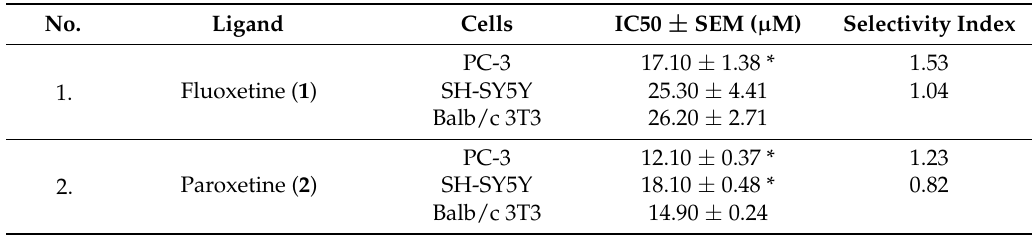
Table 2. Effect of new and classic selective serotonin reuptake inhibitors (SSRIs) and ligands of 5-HT 1A receptor on PC-3, SH-SY5Y and Balb/c 3T3 cells.